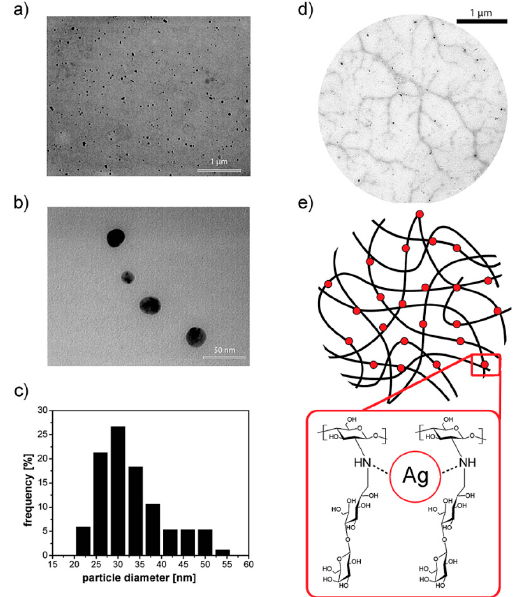
Figure 7. ( a , b ) Transmission electron microscopy (TEM) images of silver nanoparticles embedded in a 1-deoxylactit-1-yl chitosan (Chitlac) solution obtained at different magnifications; ( c ) silver nanoparticles size distribution histogram based on the TEM image in ( b ); ( d ) TEM image of silver nanoparticles formed on the polymeric chains of Chitlac; ( e ) schematic representation of the polymeric chains of Chitlac and its interaction with Ag. Reproduced with permission from